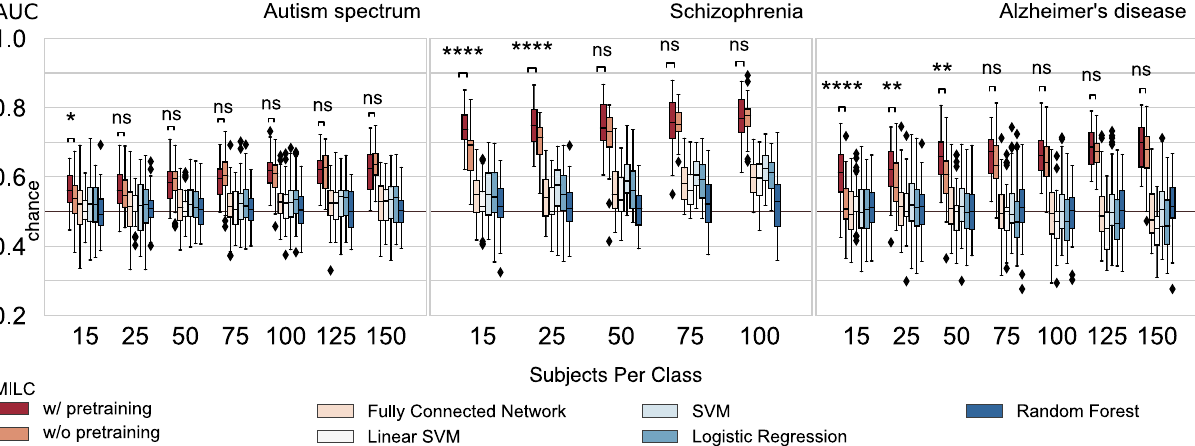
Figure 2. The main results from the whole MILC architecture and its comparison with standard machine learning models (SML). Apparently, the whole MILC model, in general, can learn from the raw data where traditional SML models fail to maintain their predictive capacity. Moreover, the whole MILC w/ pretraining substantially improves the latent representations as reflected in the improved accuracy compared to the whole MILC w/o pretraining. Specifically, in most small data cases, the whole MILC w/ pretraining outperformed the whole MILC w/o pretraining across the datasets. However, as expected, when we gradually increased the number of subjects during training, the effect of pretraining on the classification performance diminished, and both configurations of whole MILC did equally well. We verified this trend over three datasets that correspond to autism spectrum disorder, schizophrenia, and Alzheimer’s disease. Please note the Wilcoxon rank test results between w/ and w/o pretraining performance of the model as marked by asterisk (*) and “ns” (not significant), 2 2 < p ≤ 5 e − 2 3 < p ≤ 1 e − 2 4 < p ≤ 1 e − 3 4 where ns : p > 5 e − , ∗ : 1 e − , ∗∗ : 1 e − , ∗ ∗ ∗ : 1 e − , ∗ ∗ ∗∗ : p ≤ 1 e −